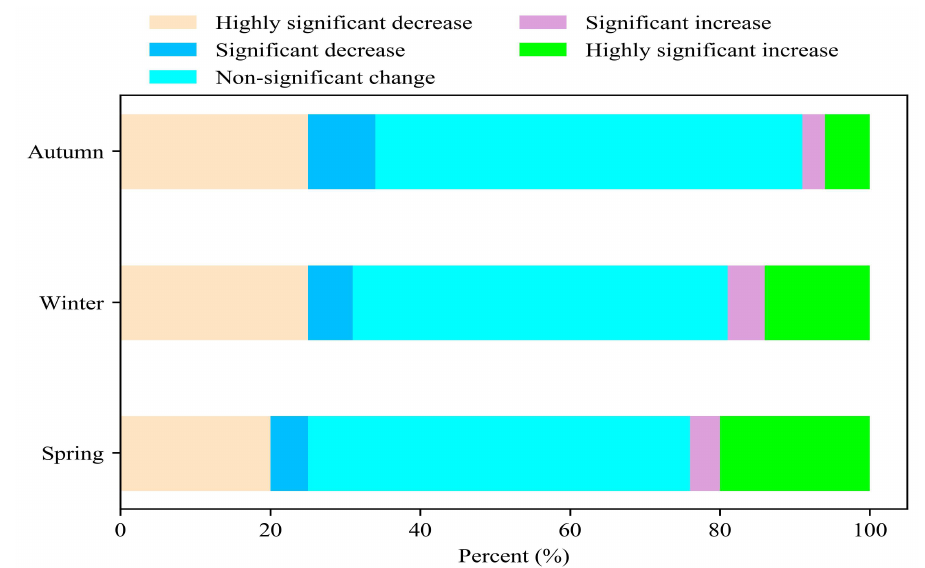
Figure 6. The variation trend grades pattern of the seasonal maximum SD over the Northern Hemisphere for three snow cover seasons, namely, autumn ( a ; September to November), winter ( b ; December to February), and spring ( c ; March to June), from 1992–2016.